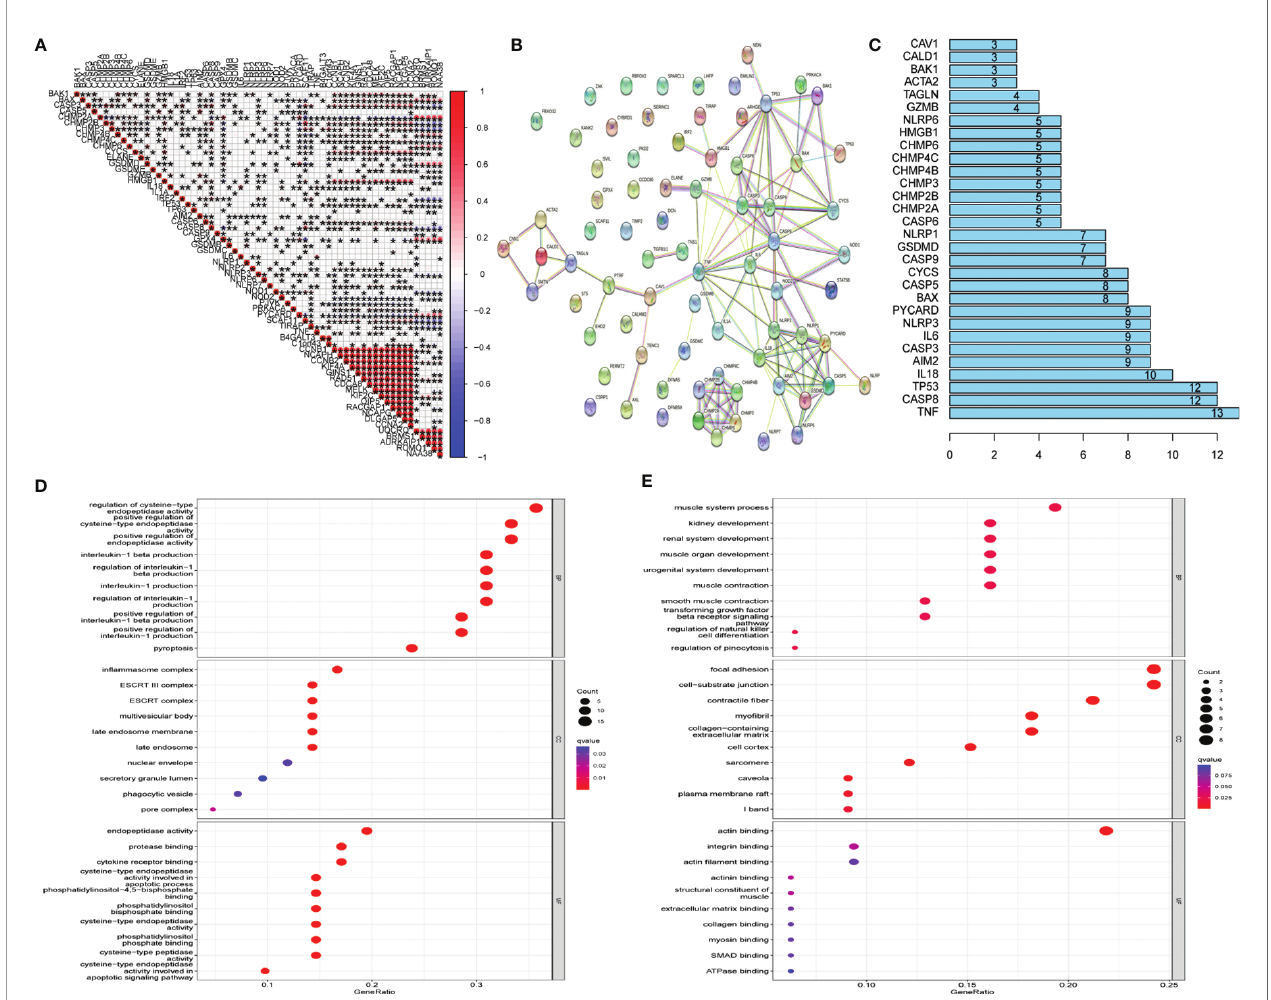
FIGURE 3 | Protein – protein interaction (PPI) analysis and gene correlation analysis. (A) Correlation among the expression of 42 uterine corpus endometrial carcinoma (UCEC)-associated pyroptosis-related genes and 21 UCEC key genes. (B) The PPIs among 42 UCEC-associated pyroptosis-related genes and 21 UCEC key genes. (C) The rank of connection degree (number) for each gene. (D) Gene Ontology (GO) analysis for 42 UCEC-associated pyroptosis-related genes. (E) GO analysis for 21 UCEC key